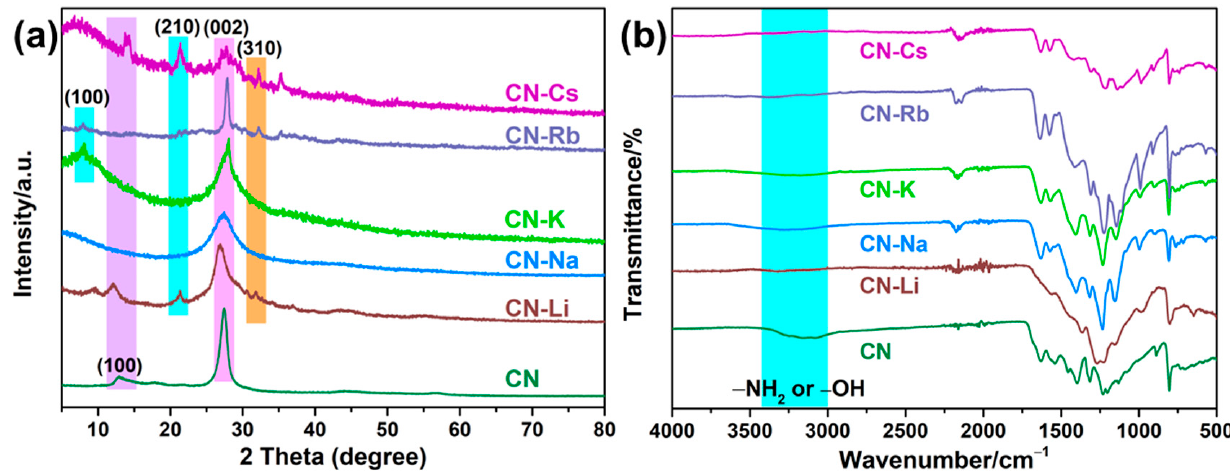
Figure 1. ( a ) XRD patterns of PCN. ( b ) FT-IR of PCN.